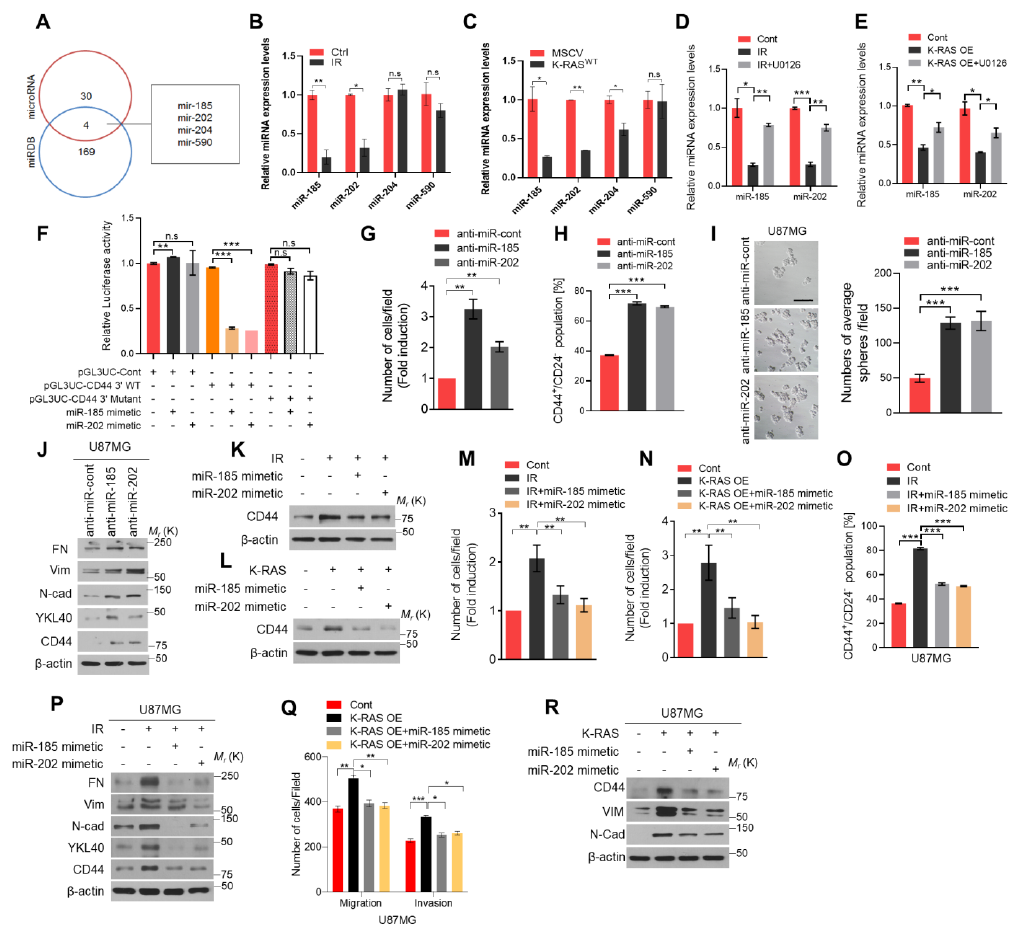
Figure 4. K-RAS-induced ERK activation regulates CD44 expression by suppression of miR-185 and miR-202 expression. ( A ). Schematic representation of miRNA prediction and screening using miRNA predictive websites (miRDB and microRNA). ( B , C ). qRT-PCR analysis of miR-185, miR-202, miR-204, and miR-590 expression using the IR-treated U87MG and K-RAS-overexpressing U87MG GBM cells, respectively. ( D , E ). qRT-PCR analysis of miR-185 and miR-202 expression using the IR-treated or K-RAS-overexpressing U87MG cells with or without U0126 (the working concentration was 10 µ M and treated for 24 h before harvest) treatment. ( F ). Relative luciferase activity after wild-type (WT) CD44-3’UTR and mutant CD44-3’UTR co-transfection with miR-185 or miR-202 mimetic in HEK293T cells. ( G–I ). Invasion assay, FACS analysis, and sphere formation assay were performed using the U87MG cells with the treatment of miR185 and miR-202 inhibitors at the control condition without IR treatment. ( J ). Western blot analysis of mesenchymal markers expression using the samples with the same experimental condition. ( K , L ). Western blot analysis of CD44 expression using the IR treated-U87MG cells and K-RAS-overexpression U87MG cells with or without miR185 and miR-202 mimetic transfection, respectively. ( M–P ). Invasion assay, FACS and western blot analysis were performed to check the mesenchymal shift and stemness features of IR-treated-U87MG cells with or without miR-185 and miR-202 mimetic transfection. ( Q , R ). Invasion and migration assay and western blot analysis were performed to measure the invasiveness ability of cells and the mesenchymal markers expression in U87MG cells with overexpression of the K-RAS alone or together with miR-185 and/or miR-202 mimetic. β -actin was used as a control for normalization of expression. * p < 0.05, ** p < 0.01, *** p < 0.001, n.s., not significant. A two-tailed Student’s t-test was used to compare data between two groups, and ANOVA was used for multiple